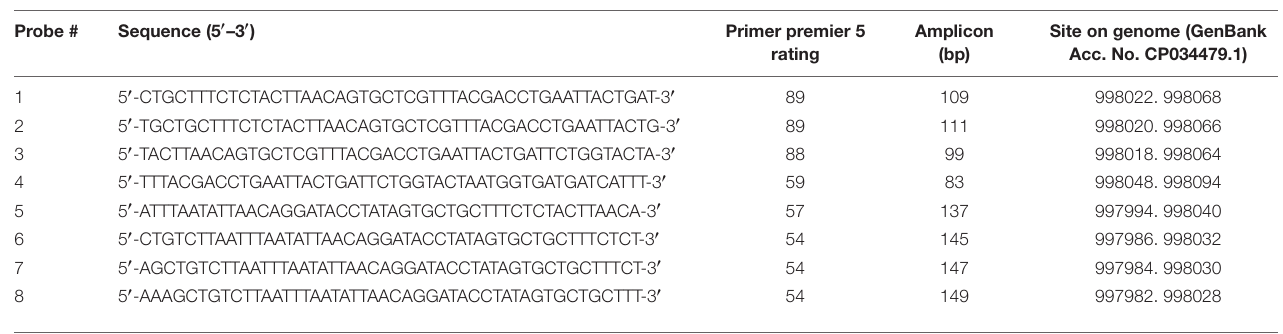
FIGURE 4 | Schematic representation of a specially designed probe that eliminates false-positive signals from primer–dimers. In a typical RPA amplification, both the amplification products (a) and the primer–dimers (b) can give positive signals. In the modified RPA reaction, amplification of the target DNA from the primer pair does not give the positive signal (c) . This amplification product (c) goes through another round of amplification guided by the probe to give a positive signal (d) . Primer–dimers in the modified RPA reaction do not give the positive signal (e) . Primer–probe complexes for most of the time do not give the positive signal. Only in a very rare case that the primer and the probe have a good matching of the bases flanking the tetrahydrofuran ([THF]) site can the complex give a positive signal (f,g) . DNA strands are presented as horizontal lines, and the base pairings are indicated as short vertical lines between the DNA strands. Anticipated amplification of the DNA strands is indicated as dotted lines. Labels and modifications on DNA as well as nfo enzyme are indicated with different shapes and colors, with the legends given at the bottom of the figure. TABLE 3 | Design of the probes.